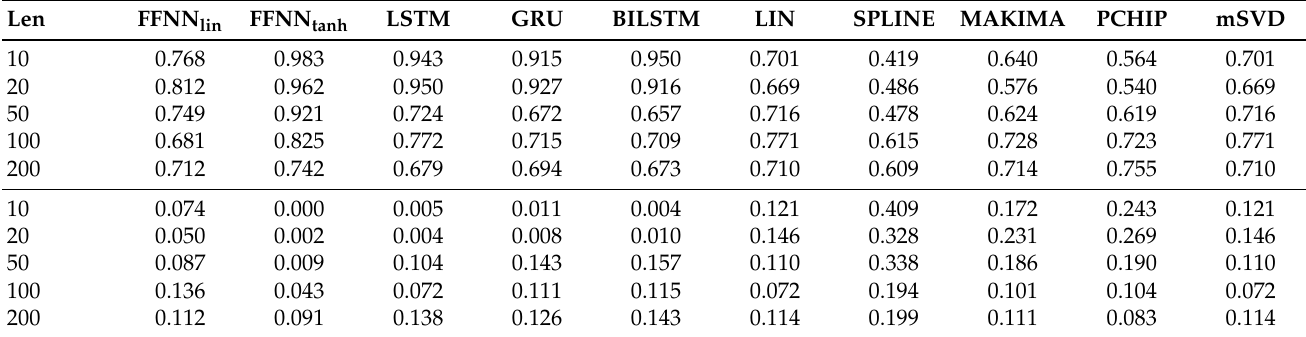
Table A8. Correlation between RMSE and velocity of input sequence.